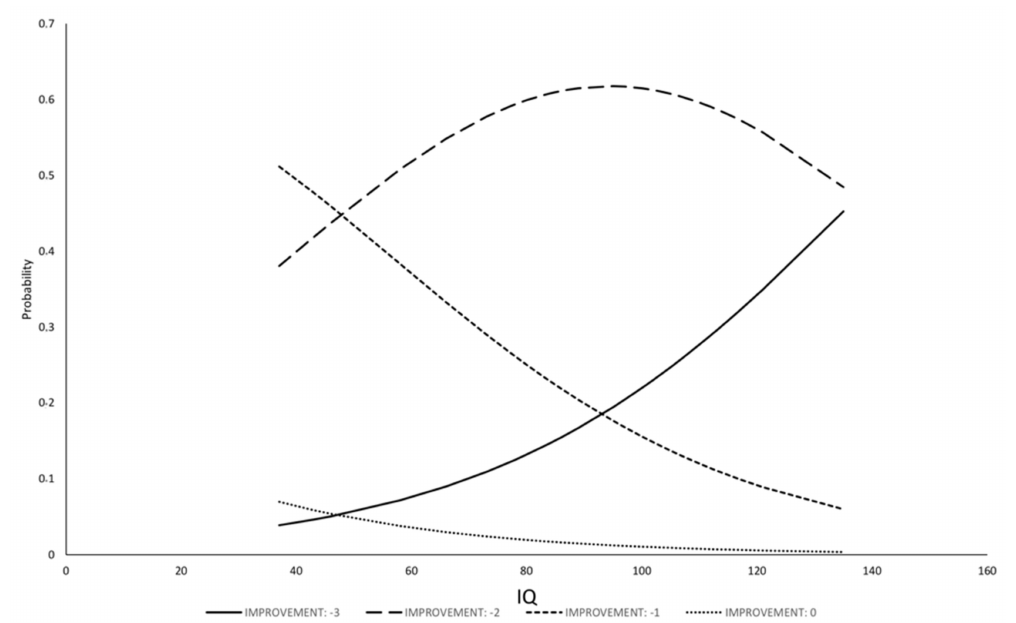
Figure 2. Relationship between probability to have a certain class of ∆ CGI-S amelioration and IQ in ADHD